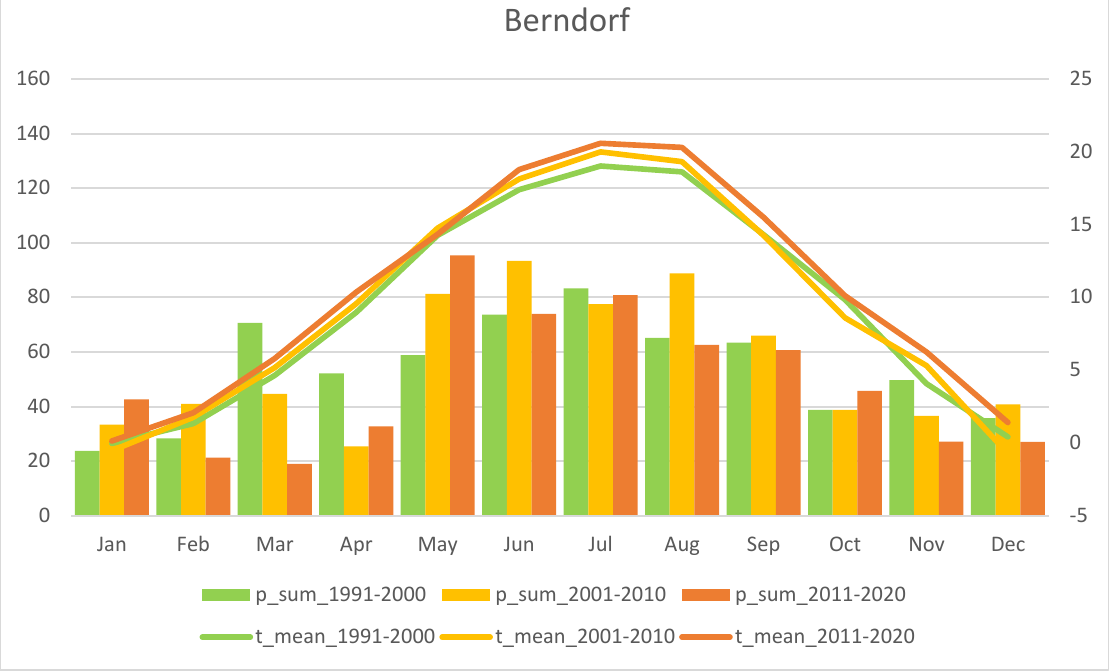
Figure A9. Mean monthly precipitation sum (p_sum; columns) and air temperature (t_mean; lines) for the last three recent decades, i.e. 1991 – 2000, 2001 – 2010, and 2011 –2020. The “Berndorf” station is representative for the Wienerwald region (source: ZAMG - https://data.hub.zamg.ac.at).